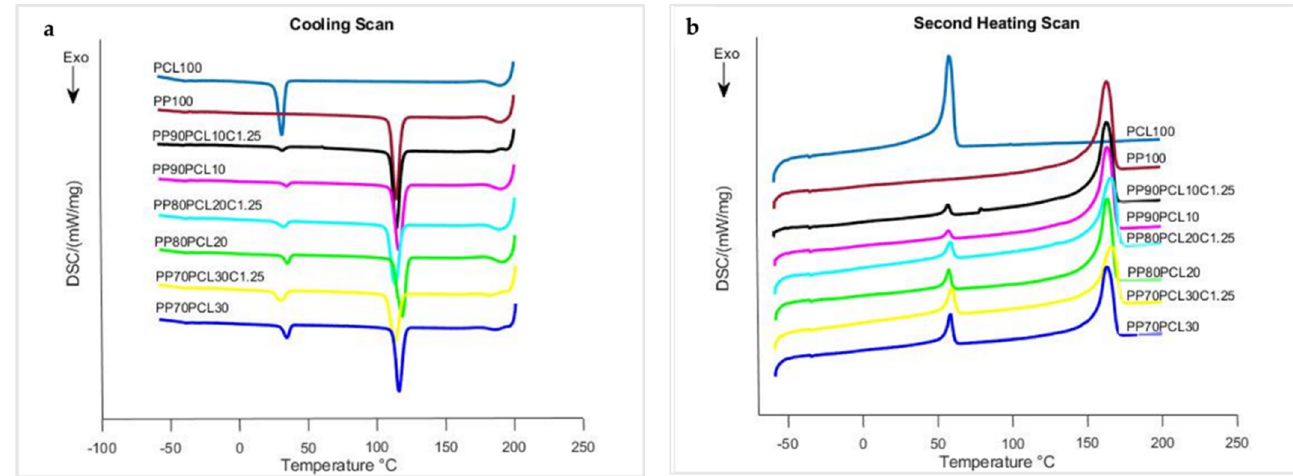
Figure 2. DSC plots of PP, PCL, PP/PCL and PP/PCL compatibilized blends: ( a ) cooling scans and ( b ) second heating scans.